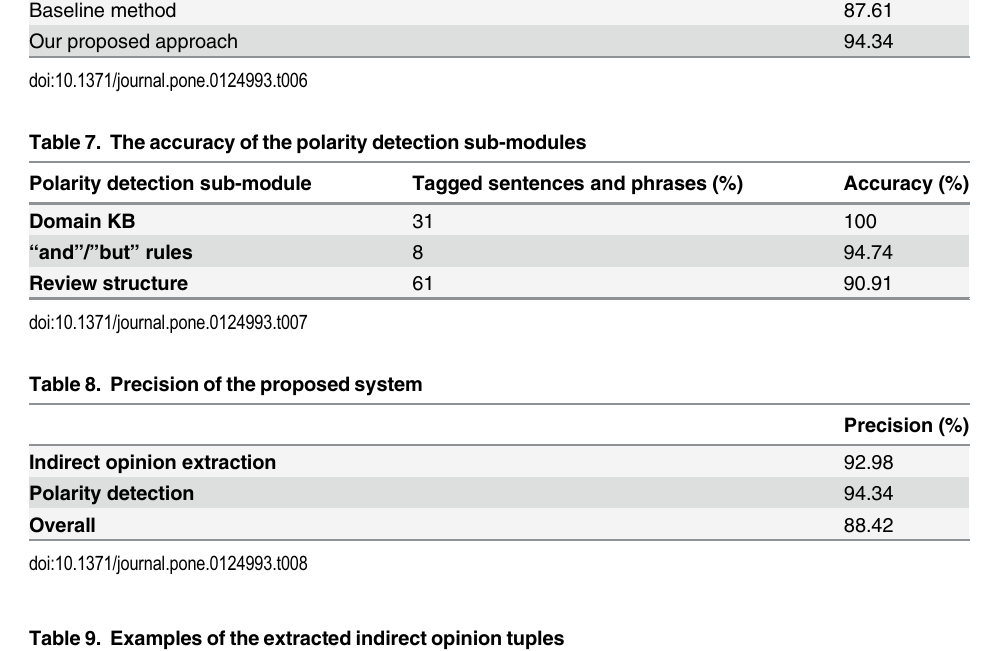
Table 9. Examples of the extracted indirect opinion tuples Indirect opinion